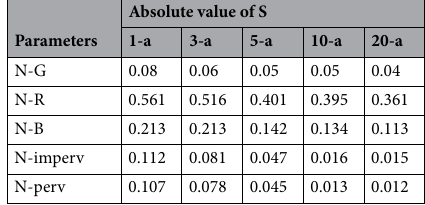
Table 4. Sensitivity analysis results of the model parameter.